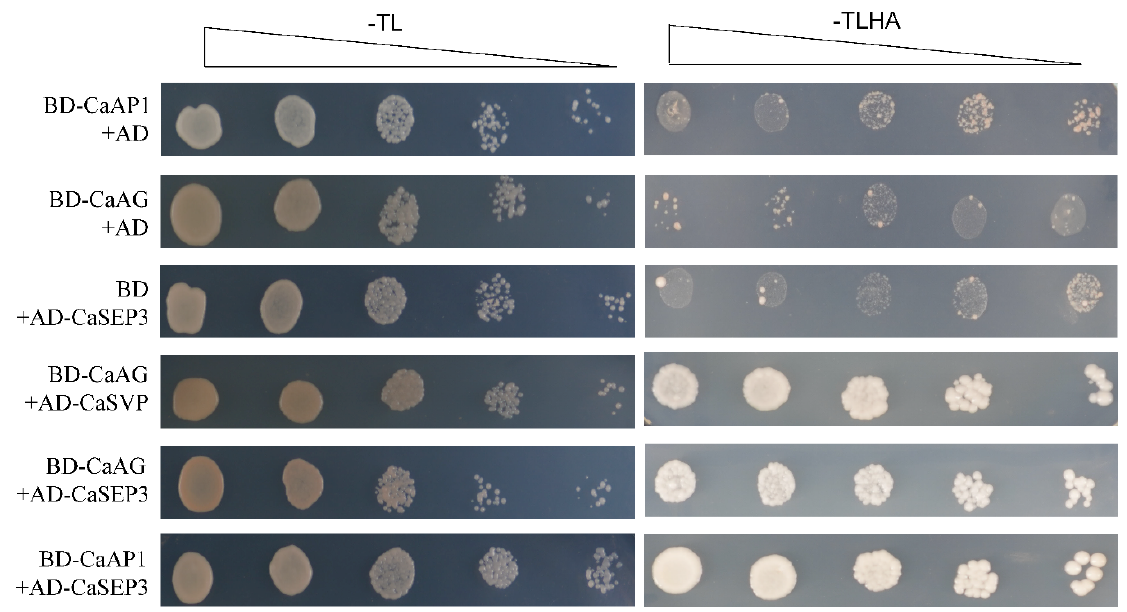
Figure 7. Type II CaMADS-box Protein Interaction Network Diagram.